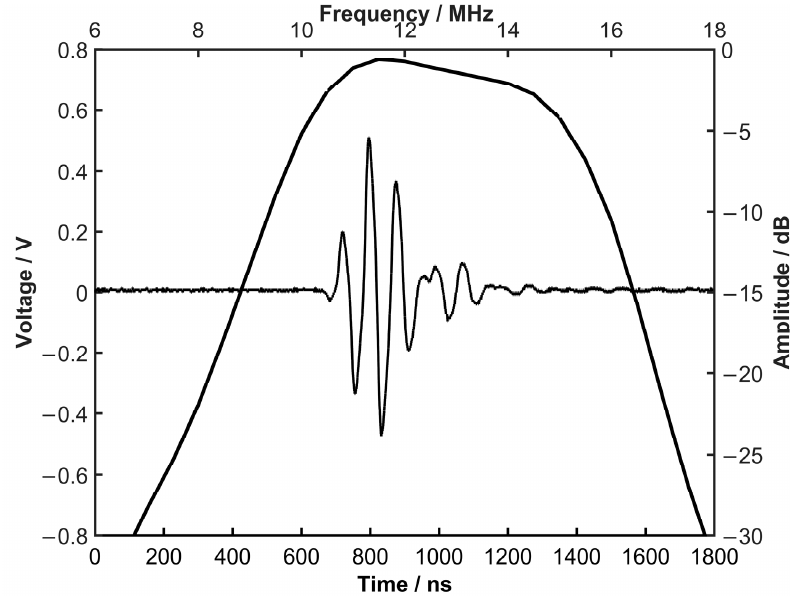
Figure 3. The measured echo and frequency wave of the fabricated transducer.